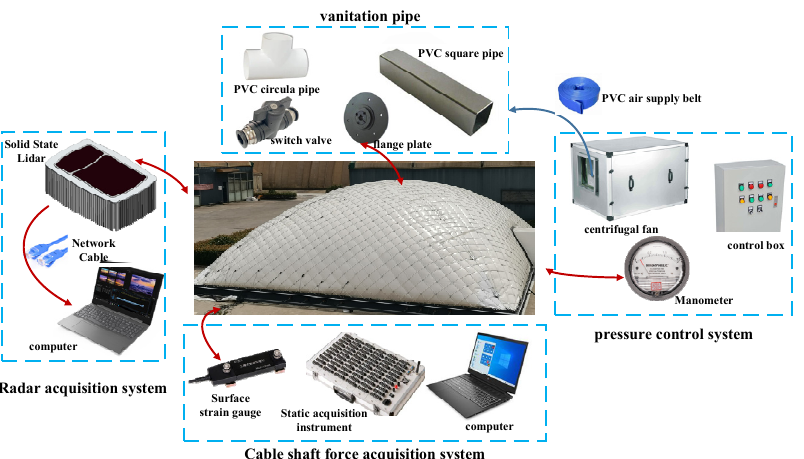
Figure 19. Experimental layout sketch.